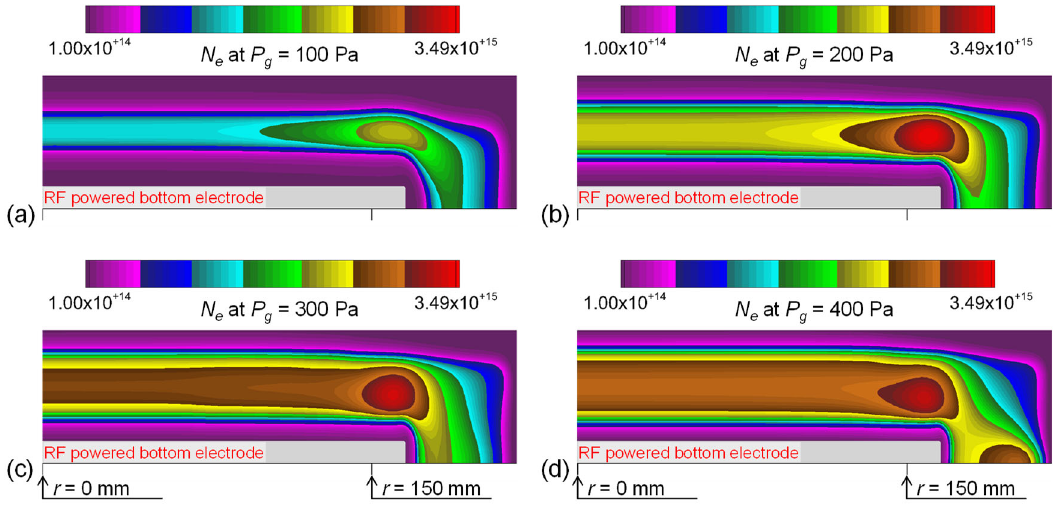
Figure 8. The spatial profiles of the time-averaged electron density ( N e , m − 3 ) ( a ) for Case 9, ( b ) for Case 10, ( c ) for Case 11, and ( d ) for Case 12.